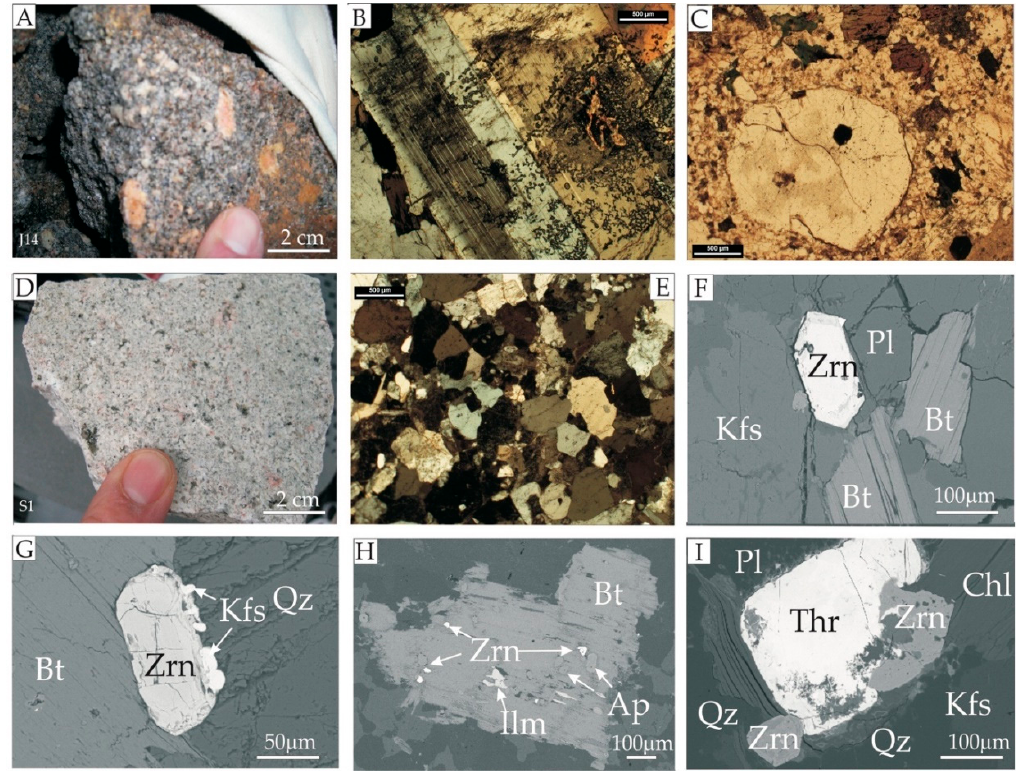
Figure 7. Photographs and photomicrographs of the studied igneous rocks from the KP and its eastern metamorphic cover (the Eastern Karkonosze). ( A – C ) coarse-grained porphyritic monzogranite (“central granite”); ( A ) sample J14 from the area of the Miedzianka polymetallic (-U) deposit; ( B ) Big crystal of twin K-feldspar. 2N (crossed nicols). Sample M12 from the Michałowice quarry; ( C ) phenocryst of quartz surrounded by sericite replacing plagioclase. Transmitted light, 1N (uncrossed nicols), Sample C13 from the area of the Czarnów polymetallic deposit; ( D ) fine-grained equigranular monzogranite (“ridge granite”) Sample S1 from the Szklarska Por ę ba Huta quarry, photograph and photomicrograph ( E ) in transmitted light, 2N; ( F ) Sample J15 from the area of the Miedzianka polymetallic (-U) deposit; zircon (Zrn) crystal in association with K-feldspar (Kfs), plagioclase (Pl) and biotite (Bt); ( G ) Sample J15; K-feldspar (Kfs) overgrowth on zircon crystallized between biotite (Bt) and quartz (Qz); ( H ) Sample C13; fine crystals of zircon (Zrn), apatite (Ap) and ilmenite (Ilm) in biotite (Bt); ( I ) Sample C13; zircon crystals intergrowing with thorite (Thr) surrounded by chlorite (Chl), quartz (Qz), K-feldspar (Kfs) and plagioclase (Pl).